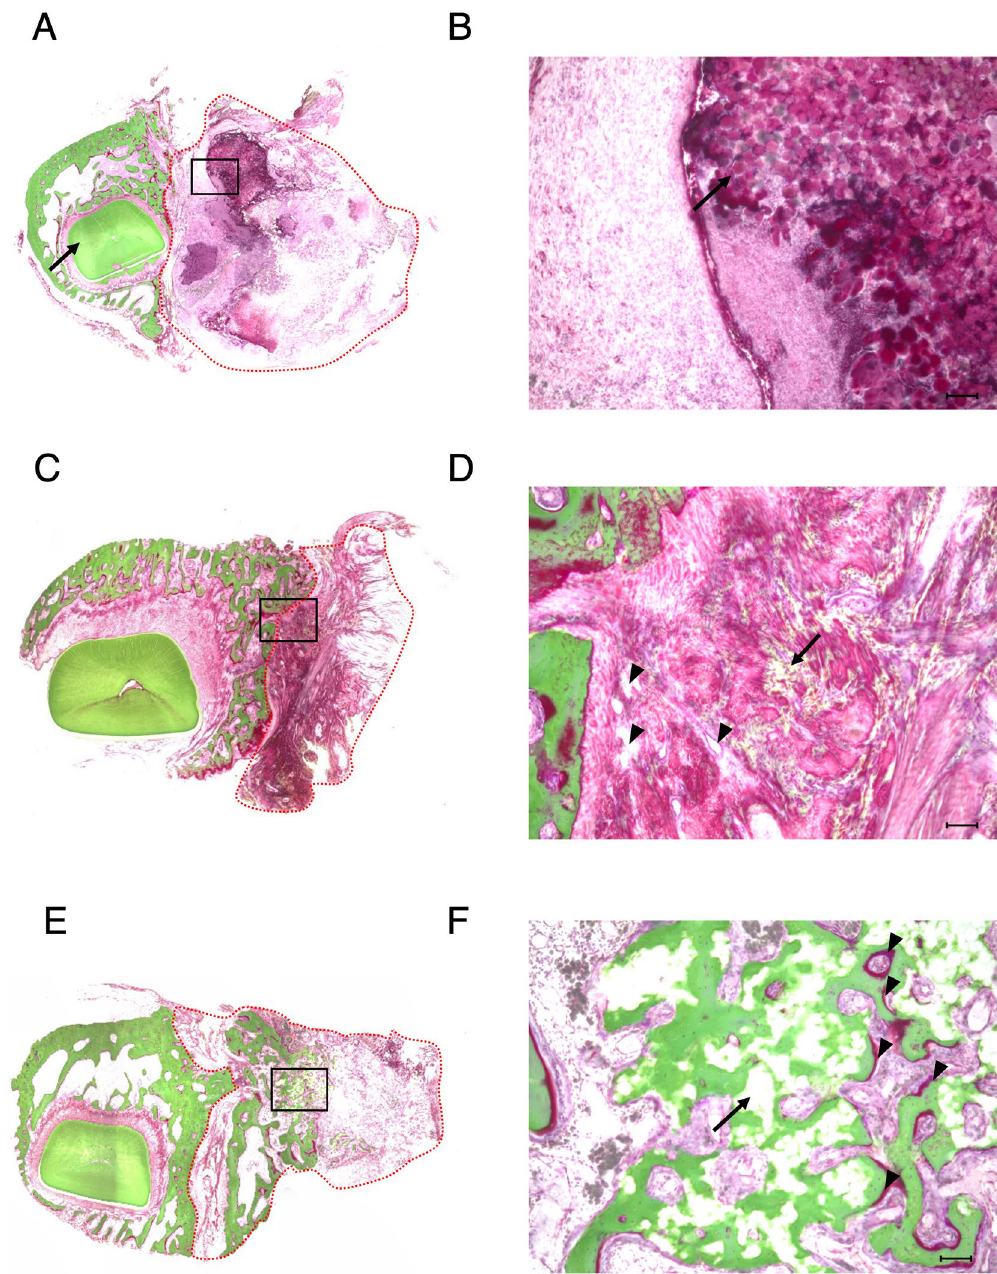
Figure 4. Histological examination with Villanueva–Goldner staining. ( A ) A representative histological image of group A (Control) is shown. The right-side mandible is designated as the control side, and the incisor root is identified (black arrow). ( B ) High magnification (10 ×) image from an enclosed rectangle area in ( A ). Remnant scaffold granules are predominant (black arrow), and little or no calcified structure is detectable. ( C ) In group B (rhBMP-2), no prominent callus formation is seen across the symphysis. ( D ) High magnification image from ( C ) shows blood vessels (black arrowheads), numerous fibroblasts, and scattered calcified tissue colored in green (black arrow). ( E ) In group C (HMGB-1), a callus formed across the symphysis. ( F ) High magnification image from ( E ) identified calcified bone surrounding the remnant scaffold material (black arrow). Osteoid (colored in red) is found adjacent to the calcified lamellar bone (black arrowheads). ( A , C , E ): magnification 2 ×; ( B , D , F ): magnification 10 ×. Scale bar = 100 μm. The red dotted line shows the area quantitatively assessed in Table